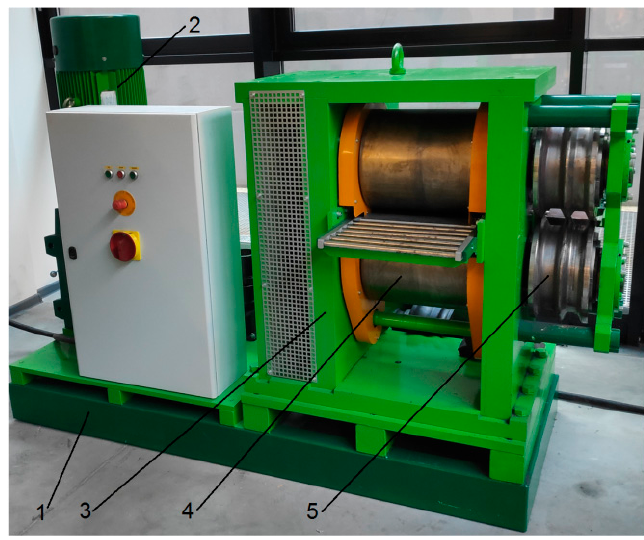
Figure 11. Console/frame longitudinal rolling mill: 1—frame, 2—drive unit, 3—rolling cage, 4—plain rolls, and 5—grooved rolls. Materials 2019 , 12 , x FOR PEER REVIEW 10 of 17